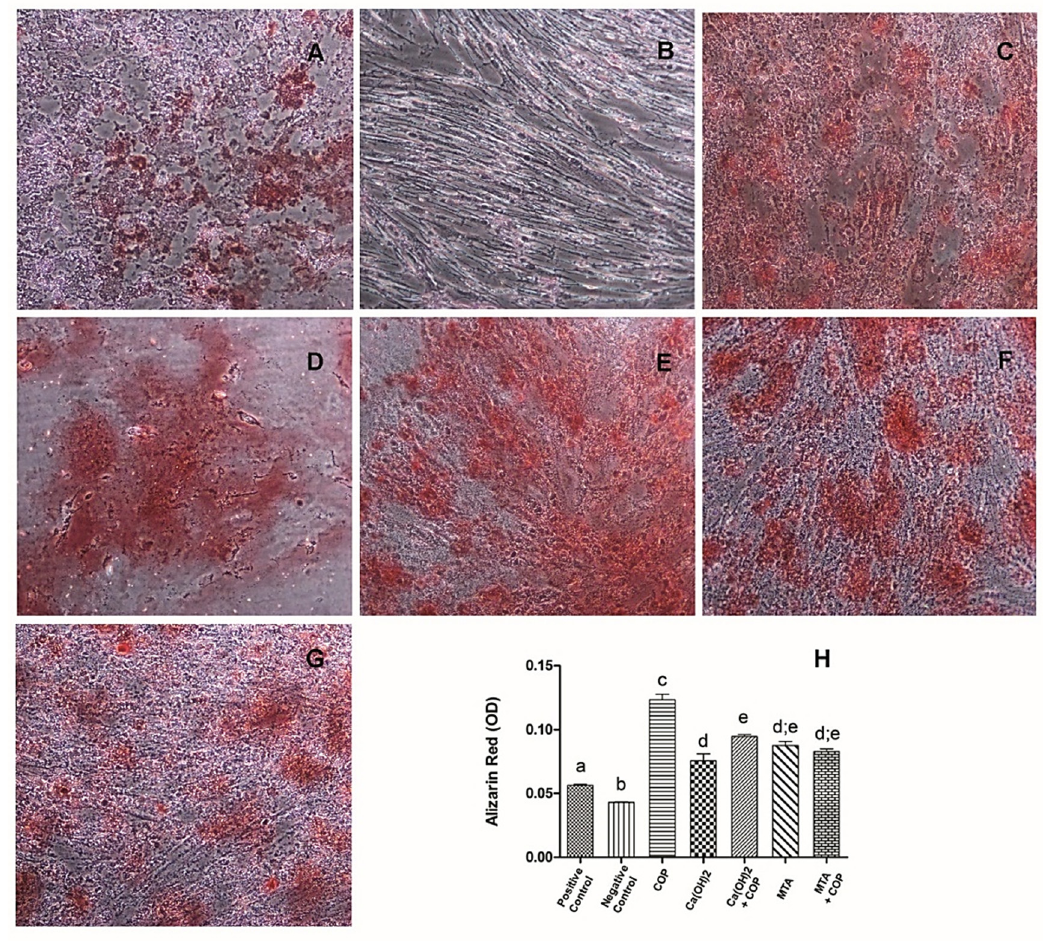
Figure 6. Illustration of cell monolayers submitted to the Alizarin red assay at 21 days after seeding. Representative phase microscopy images of the mineral deposits (in red) in cultured cells of the positive control ( A ); negative control ( B ); Copaiba (COP) ( C ); Ca(OH) 2 ( D ); Ca(OH) 2 + COP ( E ); MTA ( F ), and MTA + COP ( G ) (original magnification 100 × ). Graphic representation of the amount of stain in all the experimental groups ( H ). Di ff erent letters indicate significant di ff erences among the groups ( p < 0.05).